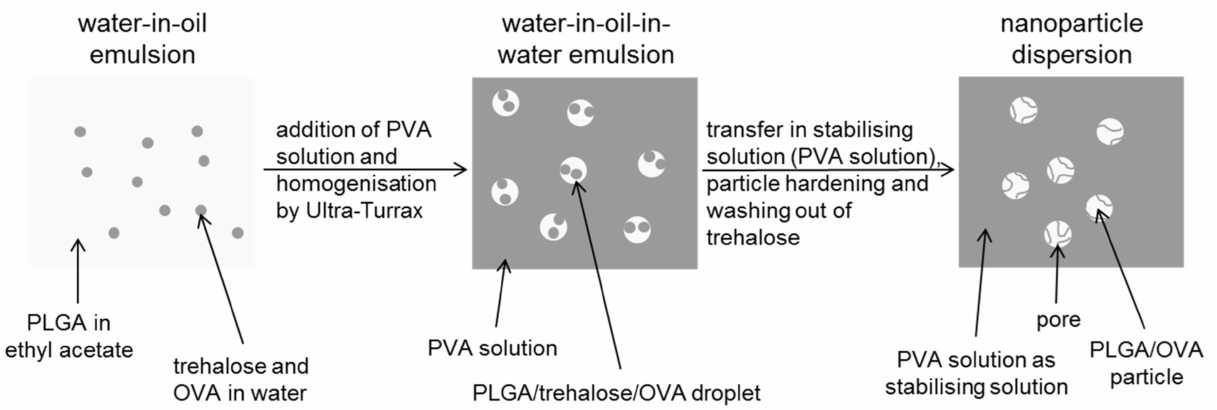
Figure 8. Preparation steps for the formulation of porous PLGA